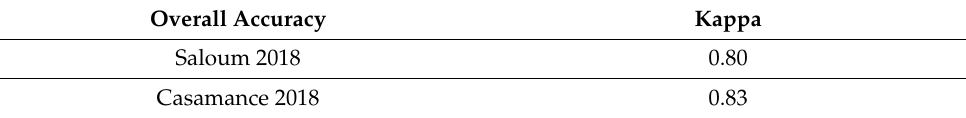
Table 5. Kappa statistics of the mangrove zonation